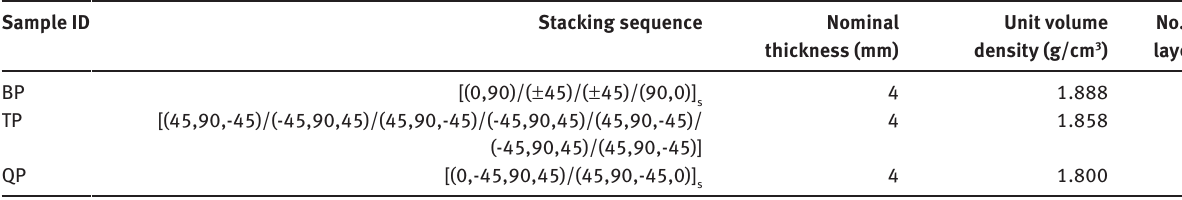
Table 1 Layer configuration and properties of the composite